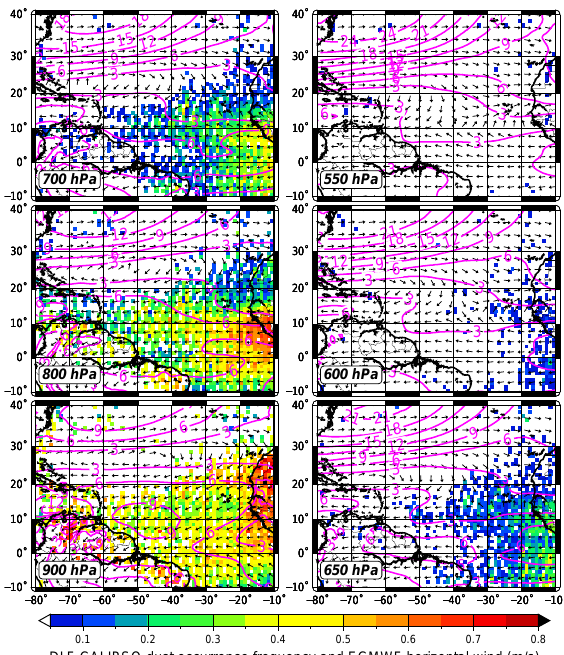
Fig. A1. Winter (DJF) CALIPSO dust occurrence frequency (col- Fig. 10. CALIPSO dust occurrence frequency at 6 pressure levels (colorscale): 900 hPa (left-bottom), 800 hPa orscale) at six pressure levels with ECMWF horizontal wind di- (left-middle), 700 hPa (left-top), 650 hPa (right-bottom), 600 hPa (right-middle) and 550 hPa (right-top). The rection (black vectors) and speed (magenta isolines). See text for black vectors show the horizontal wind direction from ECMWF reanalysis and the magenta isolines the wind details. speed ( ms − 1 ) with step of 3 ms − 1 .